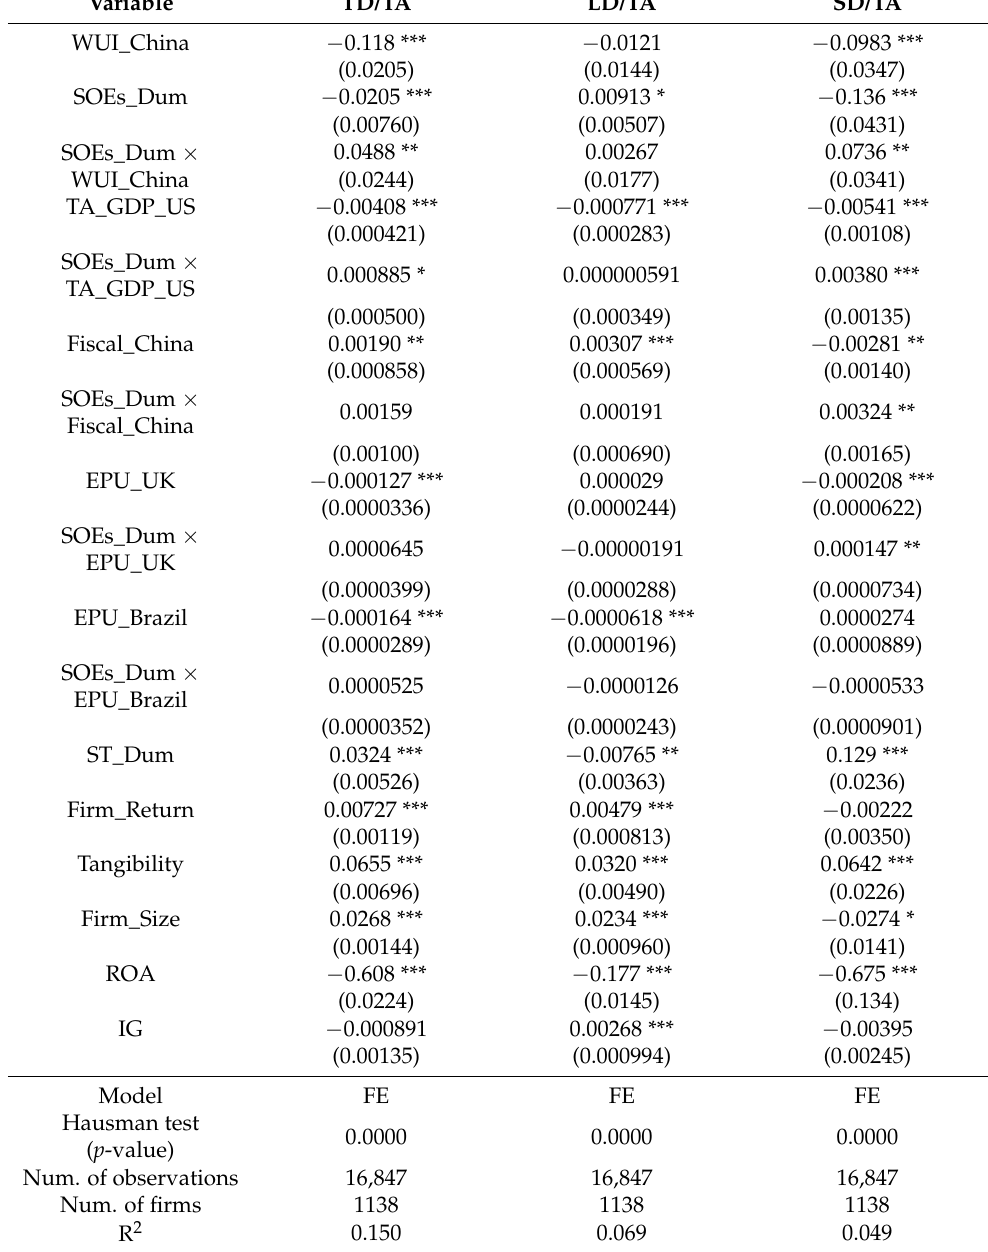
Table 3. The impacts of the economic uncertainty on capital structure by state